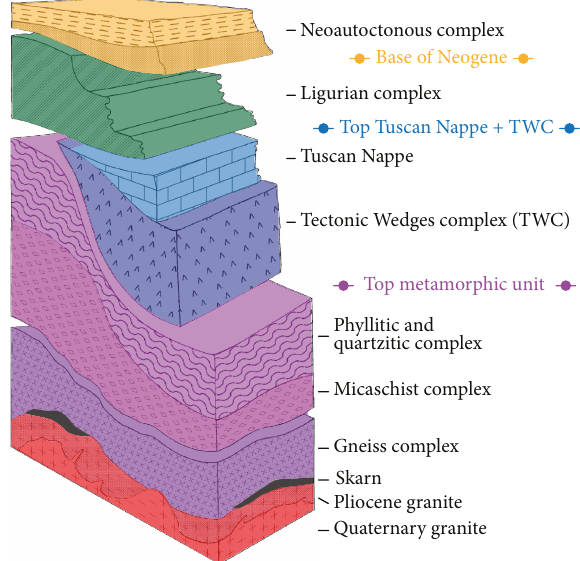
Figure 3: Conceptual sketch of the tectonic and stratigraphic setting of the Larderello area (modi fi ed after [10]). The surfaces modelled in the present work are the topographic surface, the Base of Neogene deposits, the top of the Tuscan Nappe plus the TWC, and the top of the Metamorphic unit. The surface representing the seismic K-horizon, not shown here, was extrapolated from the literature